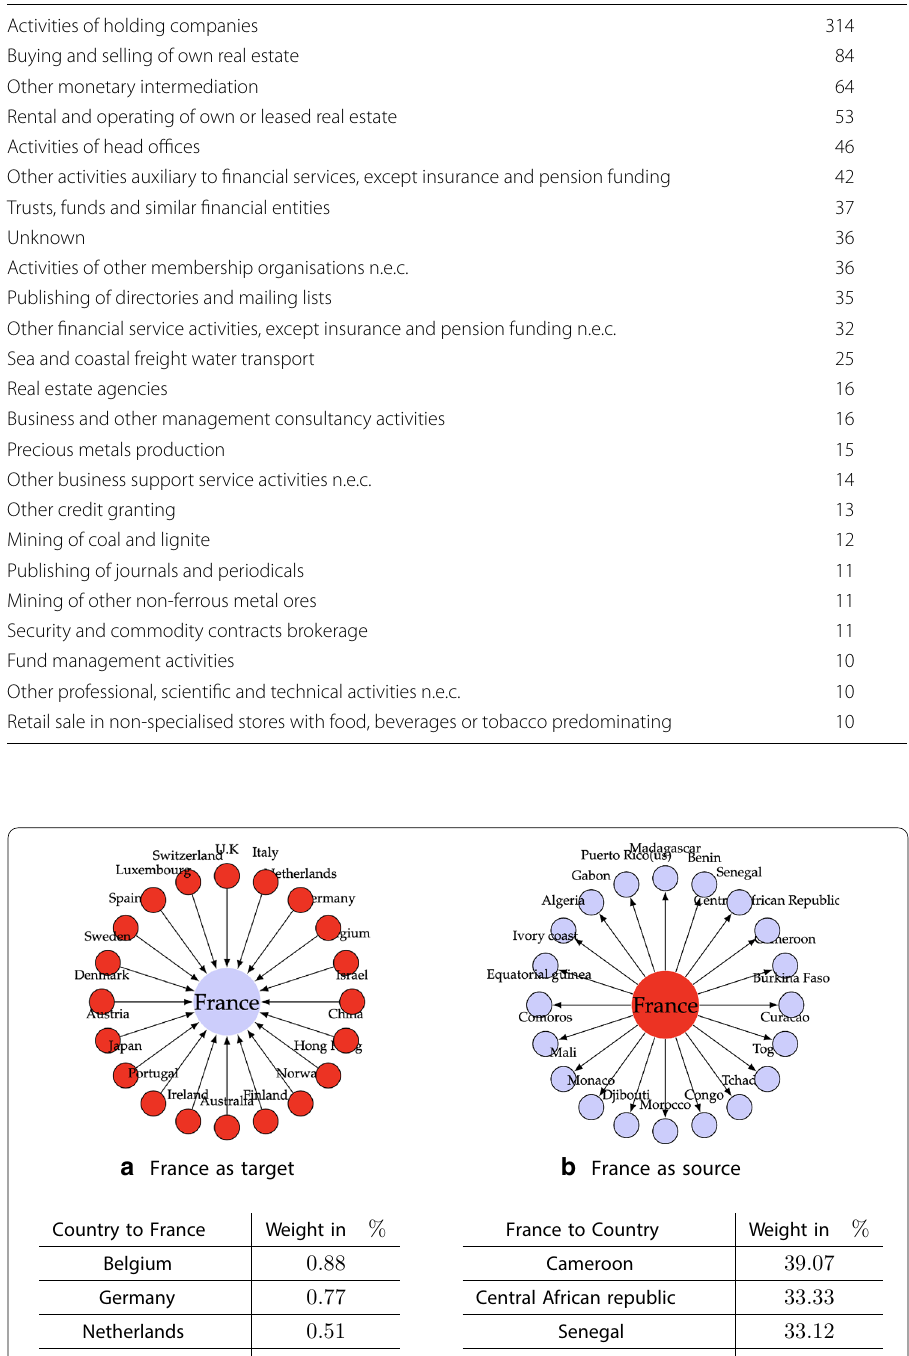
Table 4 Most frequent sectors in top k-cores (992 entities) Sector